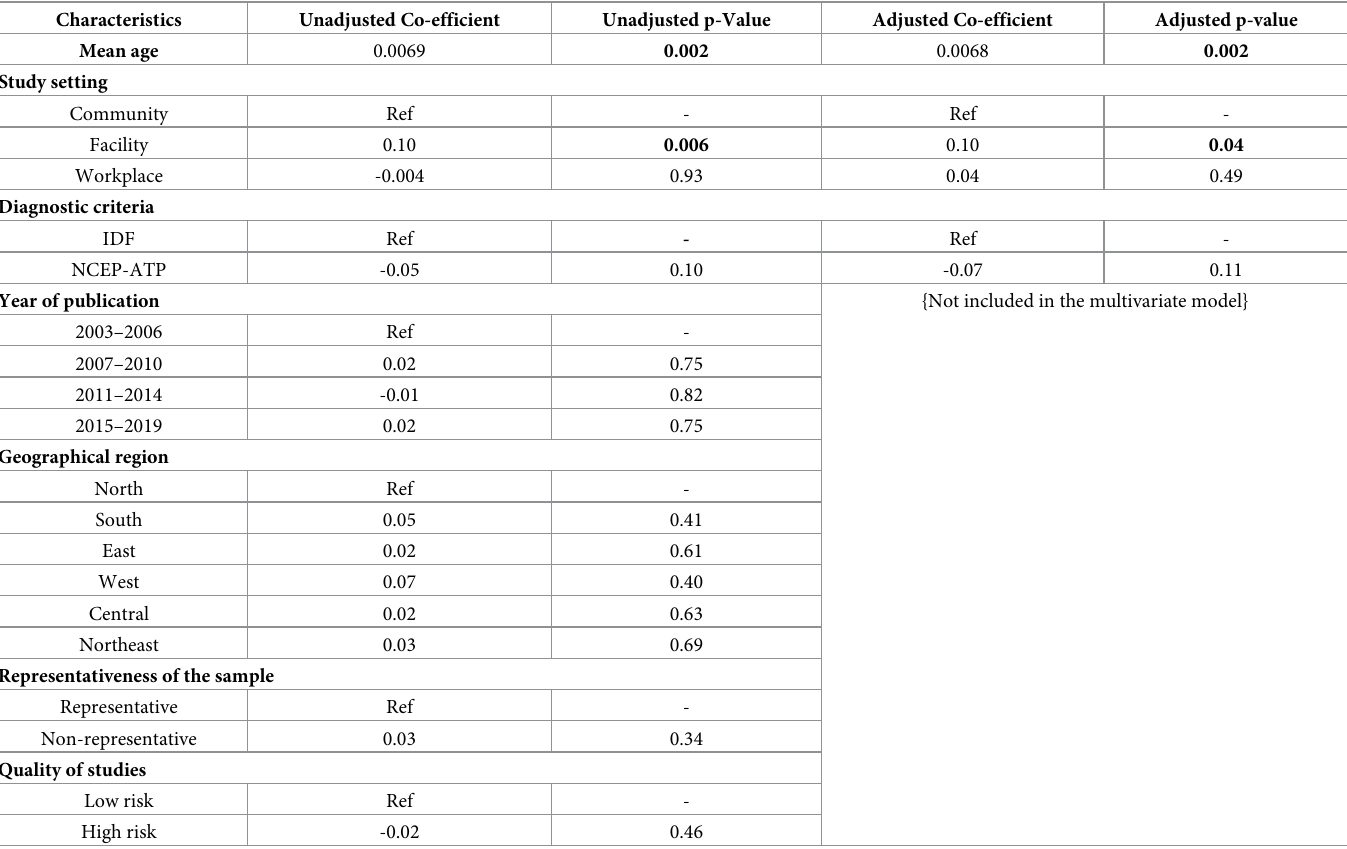
Table 3. Univariate and multivariate meta-regression performed to explore the heterogeneity between the studies (N = 113).